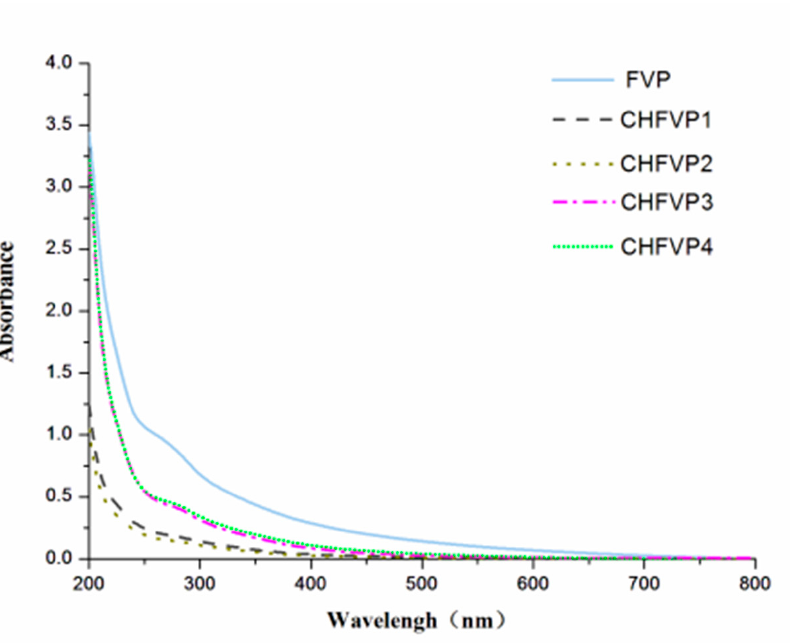
Figure 2. Wavelength scanning curve of CHFVP-1, CHFVP-2, CHFVP-3, CHFVP-4, and FVP.